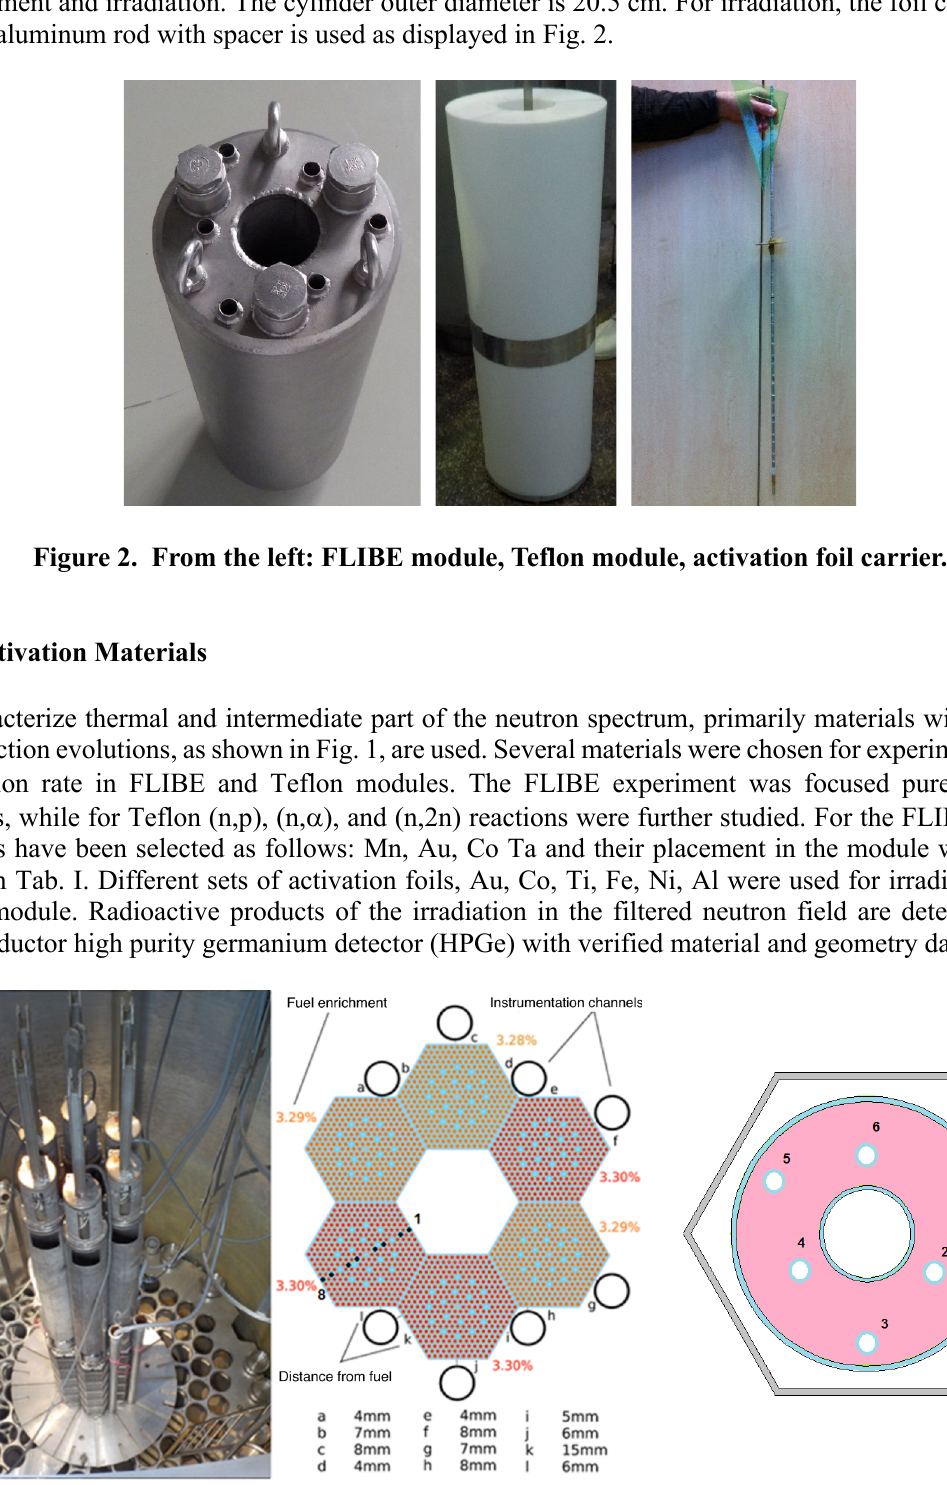
Figure 3. Overhead view of the core, its scheme and scheme of the FLIBE